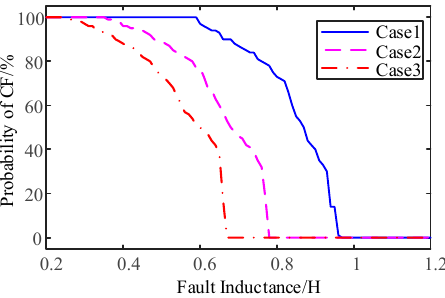
Figure 7. The probability of commutation failure (CF) in different cases under single phase to ground fault.